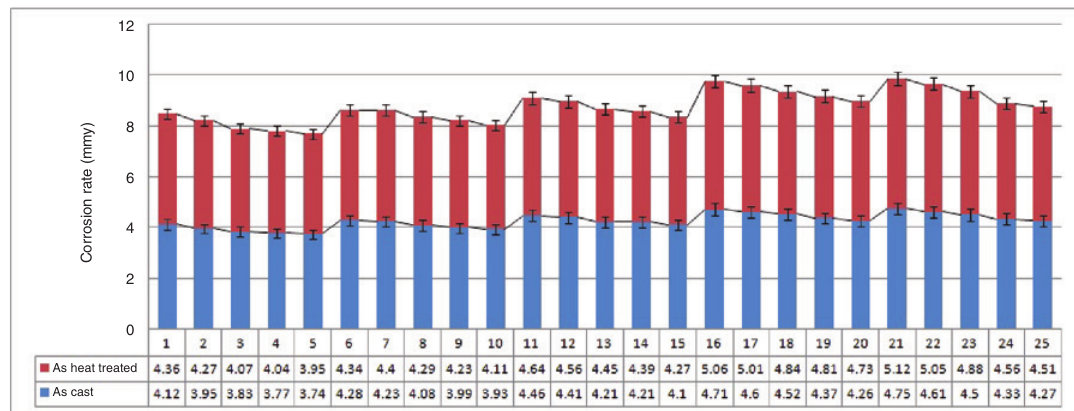
Figure 11: Corrosion behavior of hybrid green